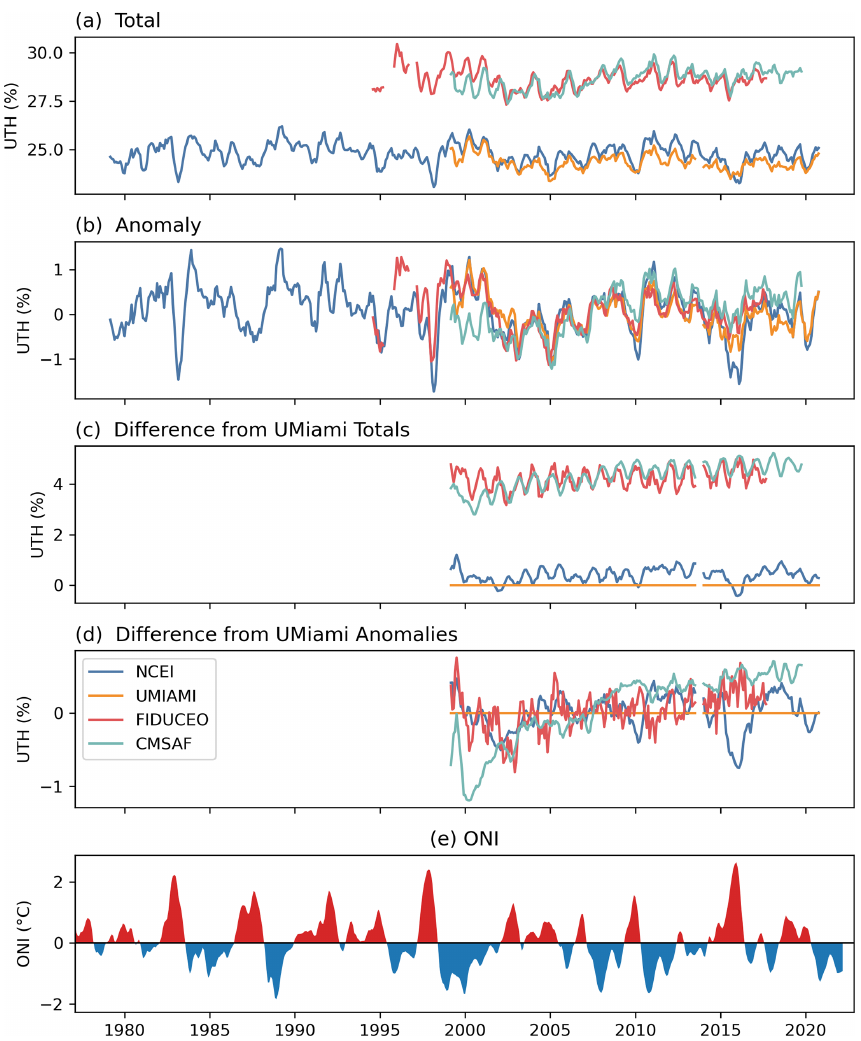
Figure 1. Time series of UTH (%) averaged over 20 ◦ S–20 ◦ N for (a) the averaged values of UTH, (b) the corresponding anomalies relative to the 2000–2015 climatology, (c) the differences of UTH values relative to the values of UMIAMI, and (d) the differences of anomaly values relative to those of UMIAMI. A 5-month moving average is applied to the UTH time series to reduce short-term fluctuations. Panel (e) shows the time series of